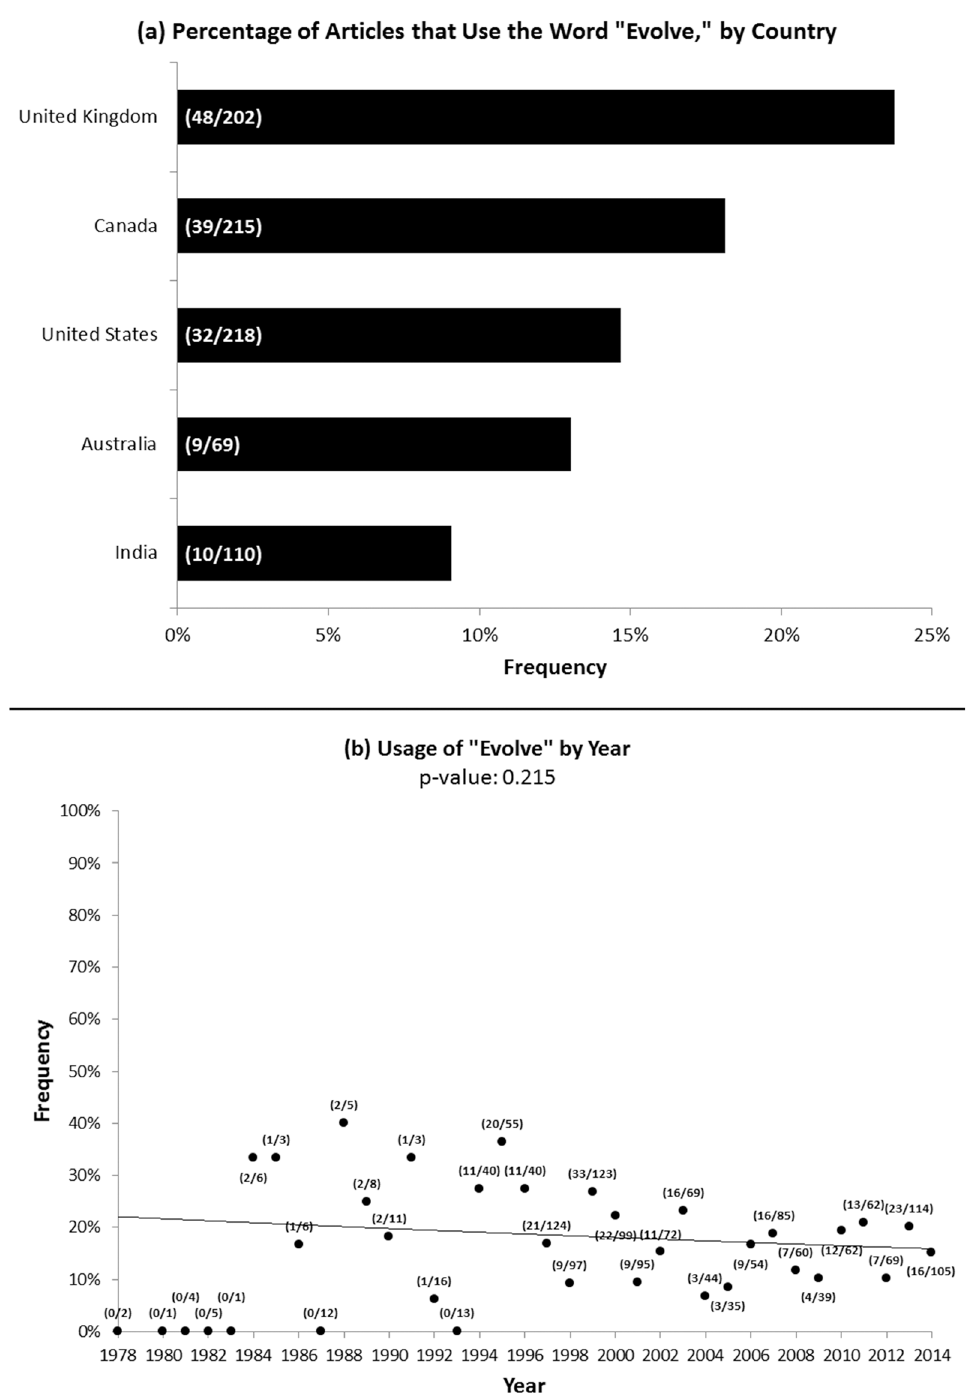
Fig 2. Percentage of Newspapers Using “ Evolve ” by Country and by Year. (a) Frequencies that the word “ evolve ” is used for the top two newspapers by circulation in each country, and (b) Frequencies that the word “ evolve ” is used each year for all relevant articles examined. Parenthetical data labels indicate: (number of relevant articles using “ evolve ” / number of relevant articles examined). Years without data points indicate that no relevant articles were examined from that year.